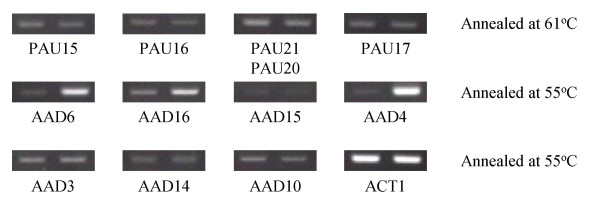
Confirmation of gene induction by RT-PCR. The RT-PCR analysis was performed using the primers described in Methods. Names of the genes are shown below the images.